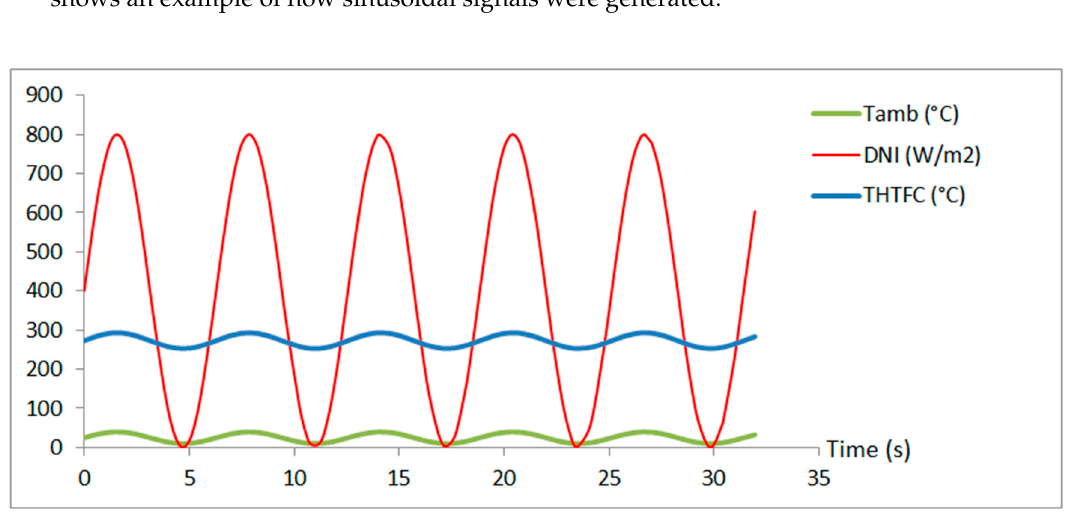
Figure 2. Sinusoidal input variables.